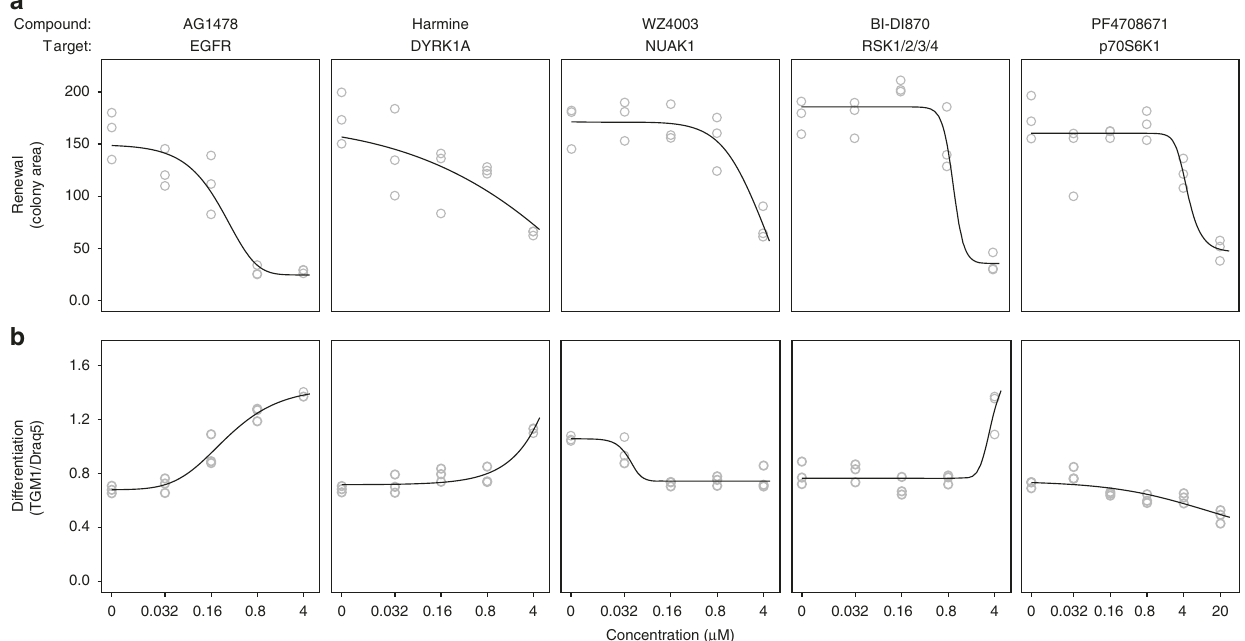
Fig. 6 Renewal assay con fi rms crucial role for DYRK1A, NUAK1, RSK and p70S6 kinases in skin stem cell renewal while the inhibitors have distinct effect on late differentiation marker TGM1. a Colony area of keratinocytes (mean area of all colonies per replicate) after 9 days of growth in the presence of speci fi c kinase inhibitors AG1478, Harmine, WZ4003, BI-DI870 and PF4708671 targeting EGFR, DYRK1A, NUAK1, RSK1/2/3/4 and p70-Ribosomal S6 kinase, respectively. Line shows modelled dose – response curves based on three biological replicates per concentration. b Levels of late differentiation marker (mean of all colonies per replicate), determined by immuno fl uorescent staining of TGM1 in CFA cell populations (corrected for cell number using Draq5 staining). Modelled dose – response curves ( n = 3) show increase in TGM1 levels for three out of fi ve